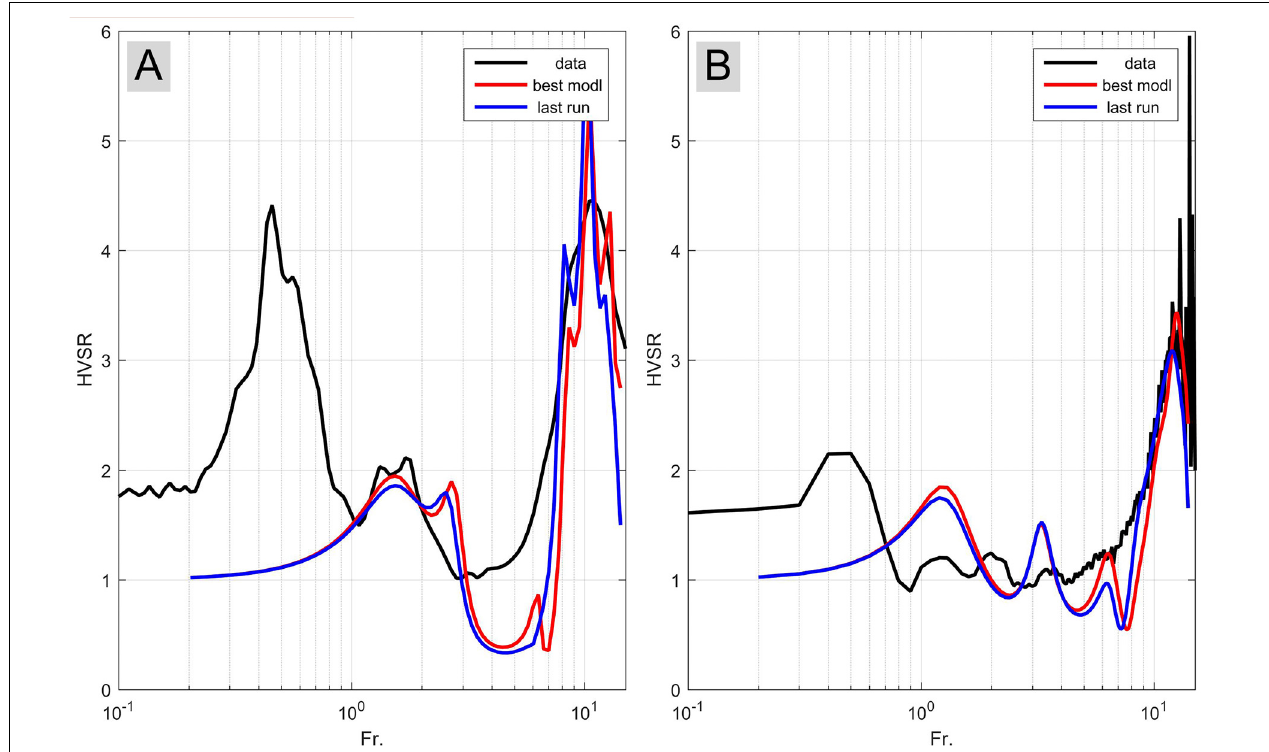
FIGURE 9 | (A) Inversion result of FFT-HVSR curve at Station MM065. (B) Inversion result of the HHT-HVSR curve at Station MM065. The black line represents the calculated HVSR curve; the blue line represents the simulated HVSR curve for the last iteration on the model, and the red line represents the simulated HVSR curve for the best-fitting